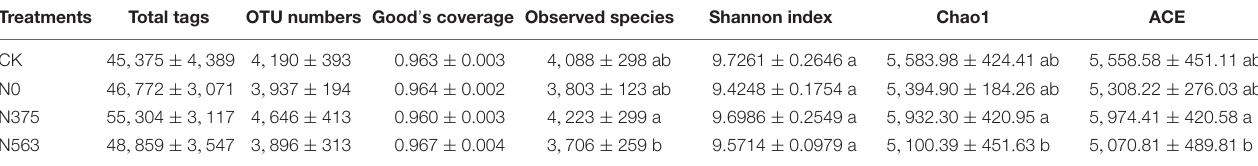
TABLE 2 | Species richness and diversity indices of the four treatments at a 97% identity threshold. Treatments Total